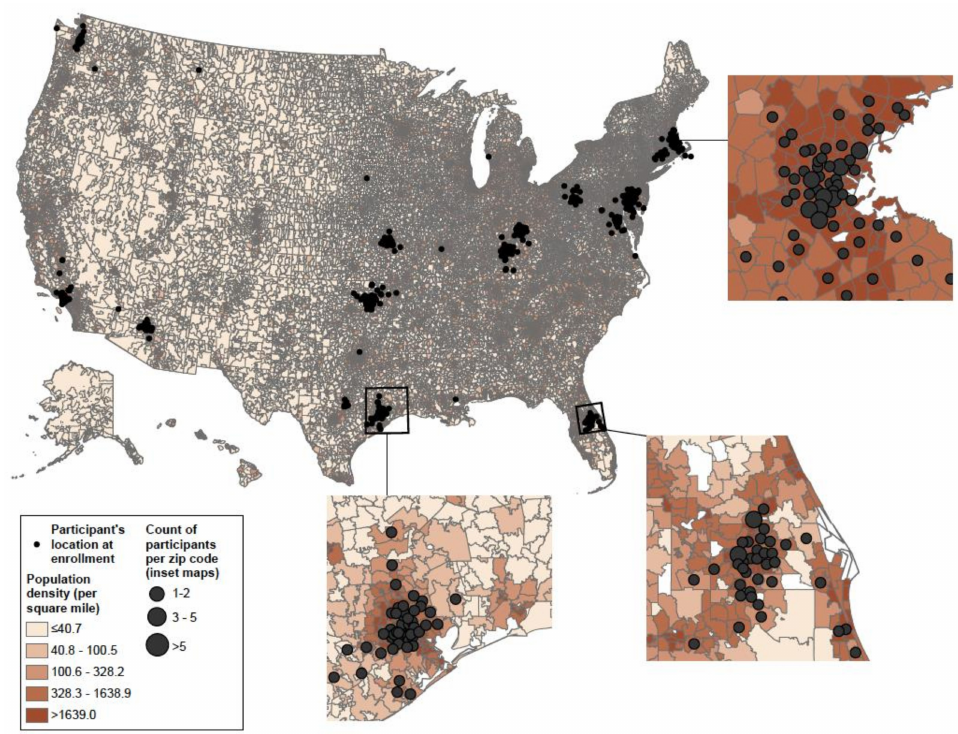
Figure 1. Distribution of participants’ enrollment addresses across the U.S. and distribution of population density obtained from 2010 census plotted by ZIP code tabulation